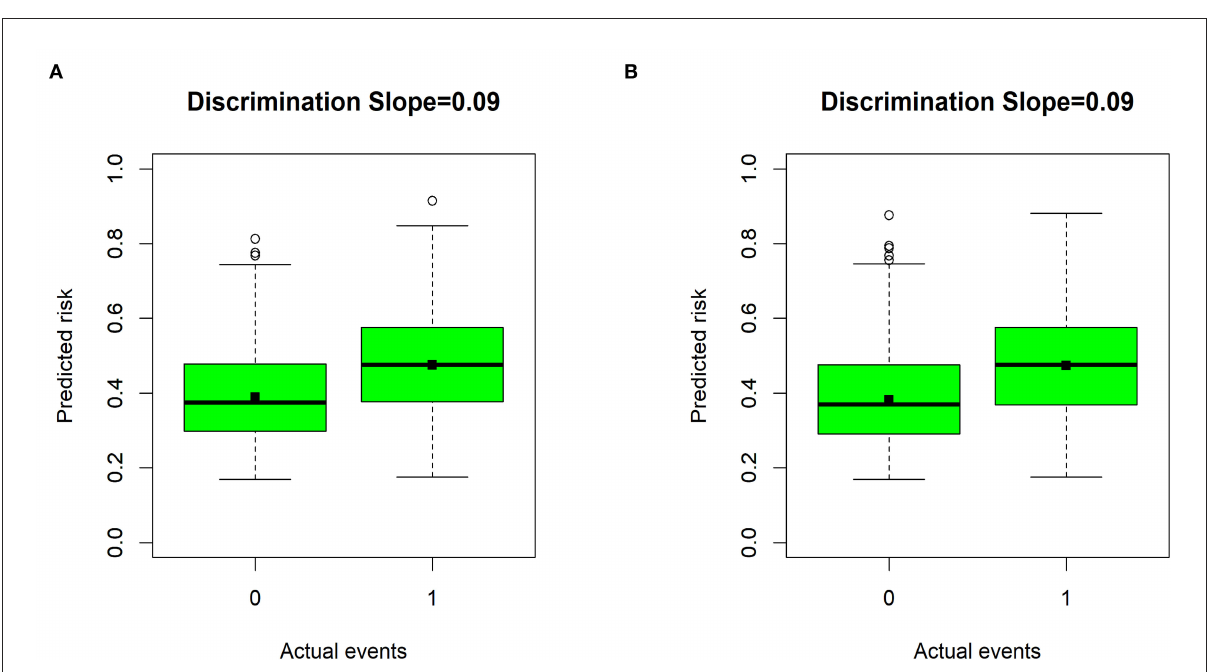
FIGURE5 Discrimination slopes for the nomogram in the two groups. (A) The training group; (B) the validation group. “0” indicates participants without medical disputes, and “1” indicates participants with medical disputes.